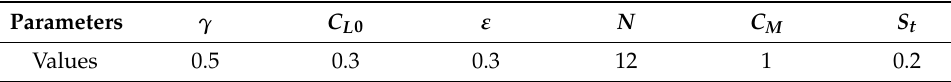
Table 1. Values of parameters in classical wake oscillator model [8].